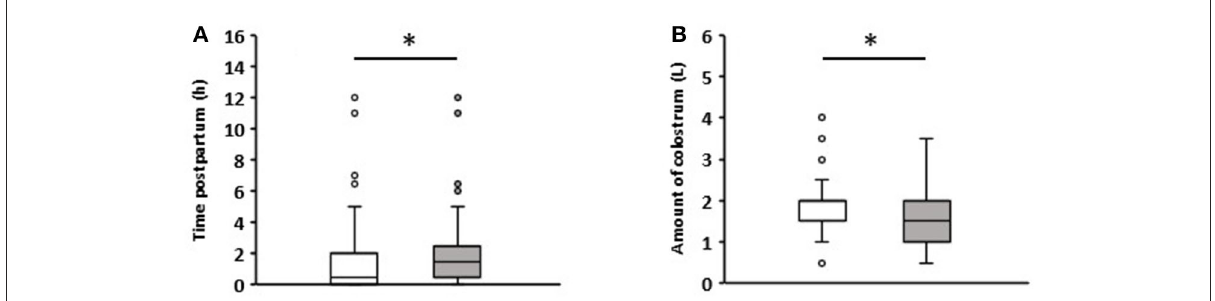
FIGURE1 Comparison of colostrum intake data of newborn calves without (white boxes, n = 81) and with diarrhea (gray boxes, n = 57) in the first week of life. (A) Time to colostrum ingestion after birth. (B) Amount of colostrum ingested (Wilcoxon test, * p < 0.05).